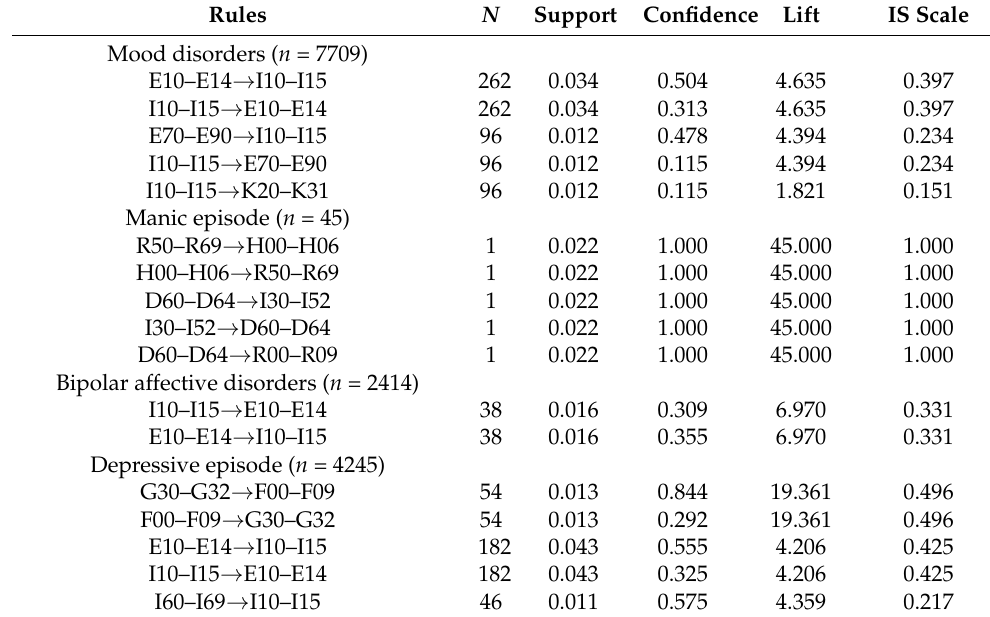
Table 3. Analysis of association rules to comorbidity in patients with mood